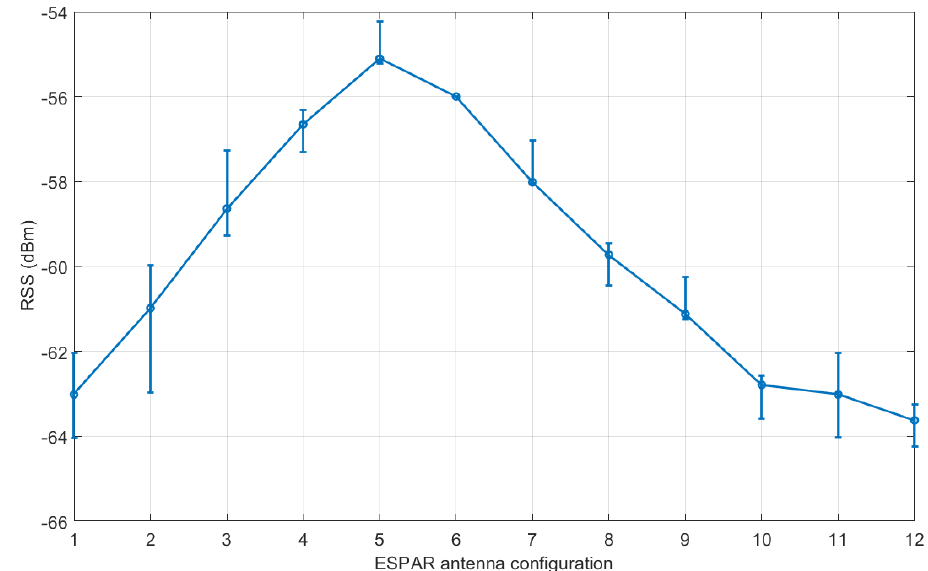
Figure 10. Received signal strength from a single reference module with respect to ESPAR antenna configurations. Error bars represent the maximal received signal strength (RSS) deviation within 100 measurement packets. The standard deviation for RSS values σ = 0.316 dB